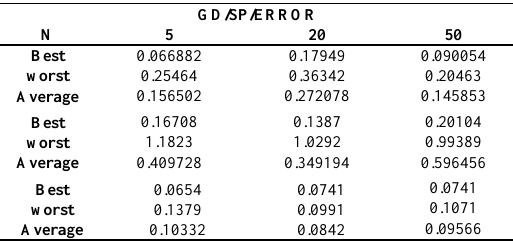
Table 9. GD/SP/ERROR analysis on the second test function. GD/SP/ERROR